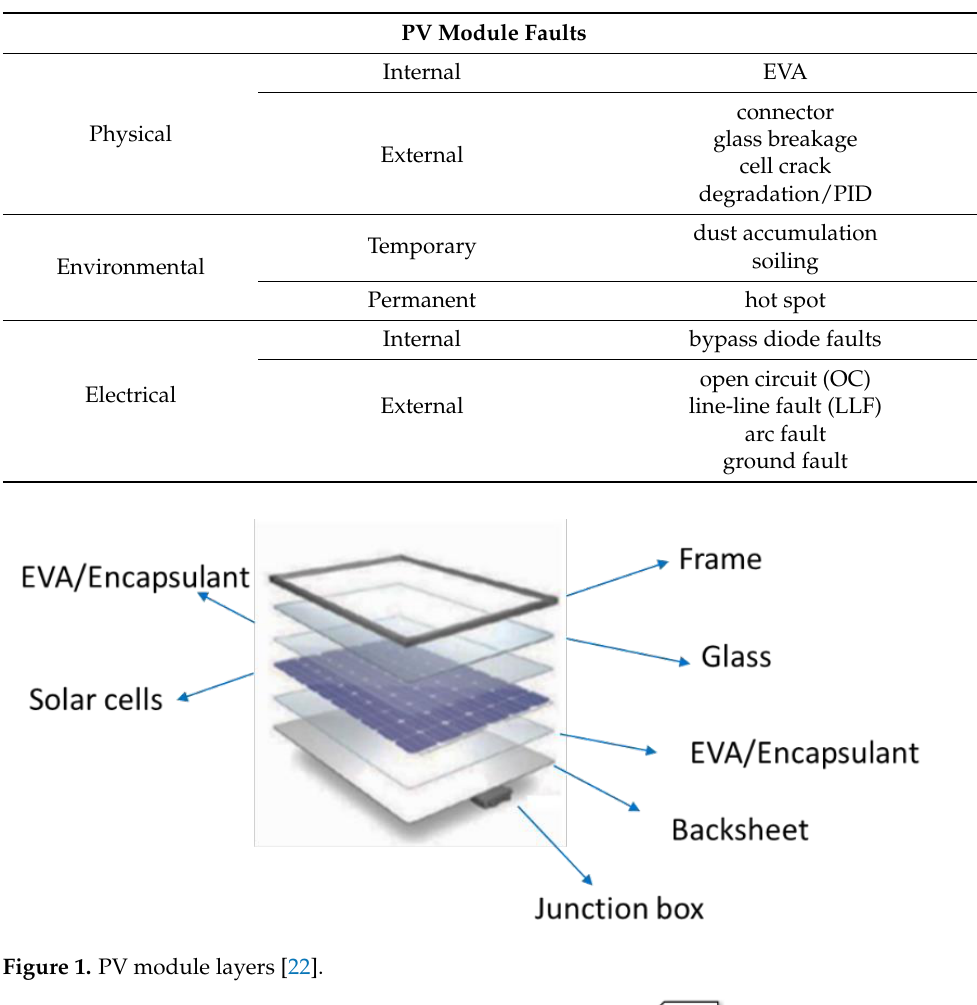
Table 2. PV module fault classification.